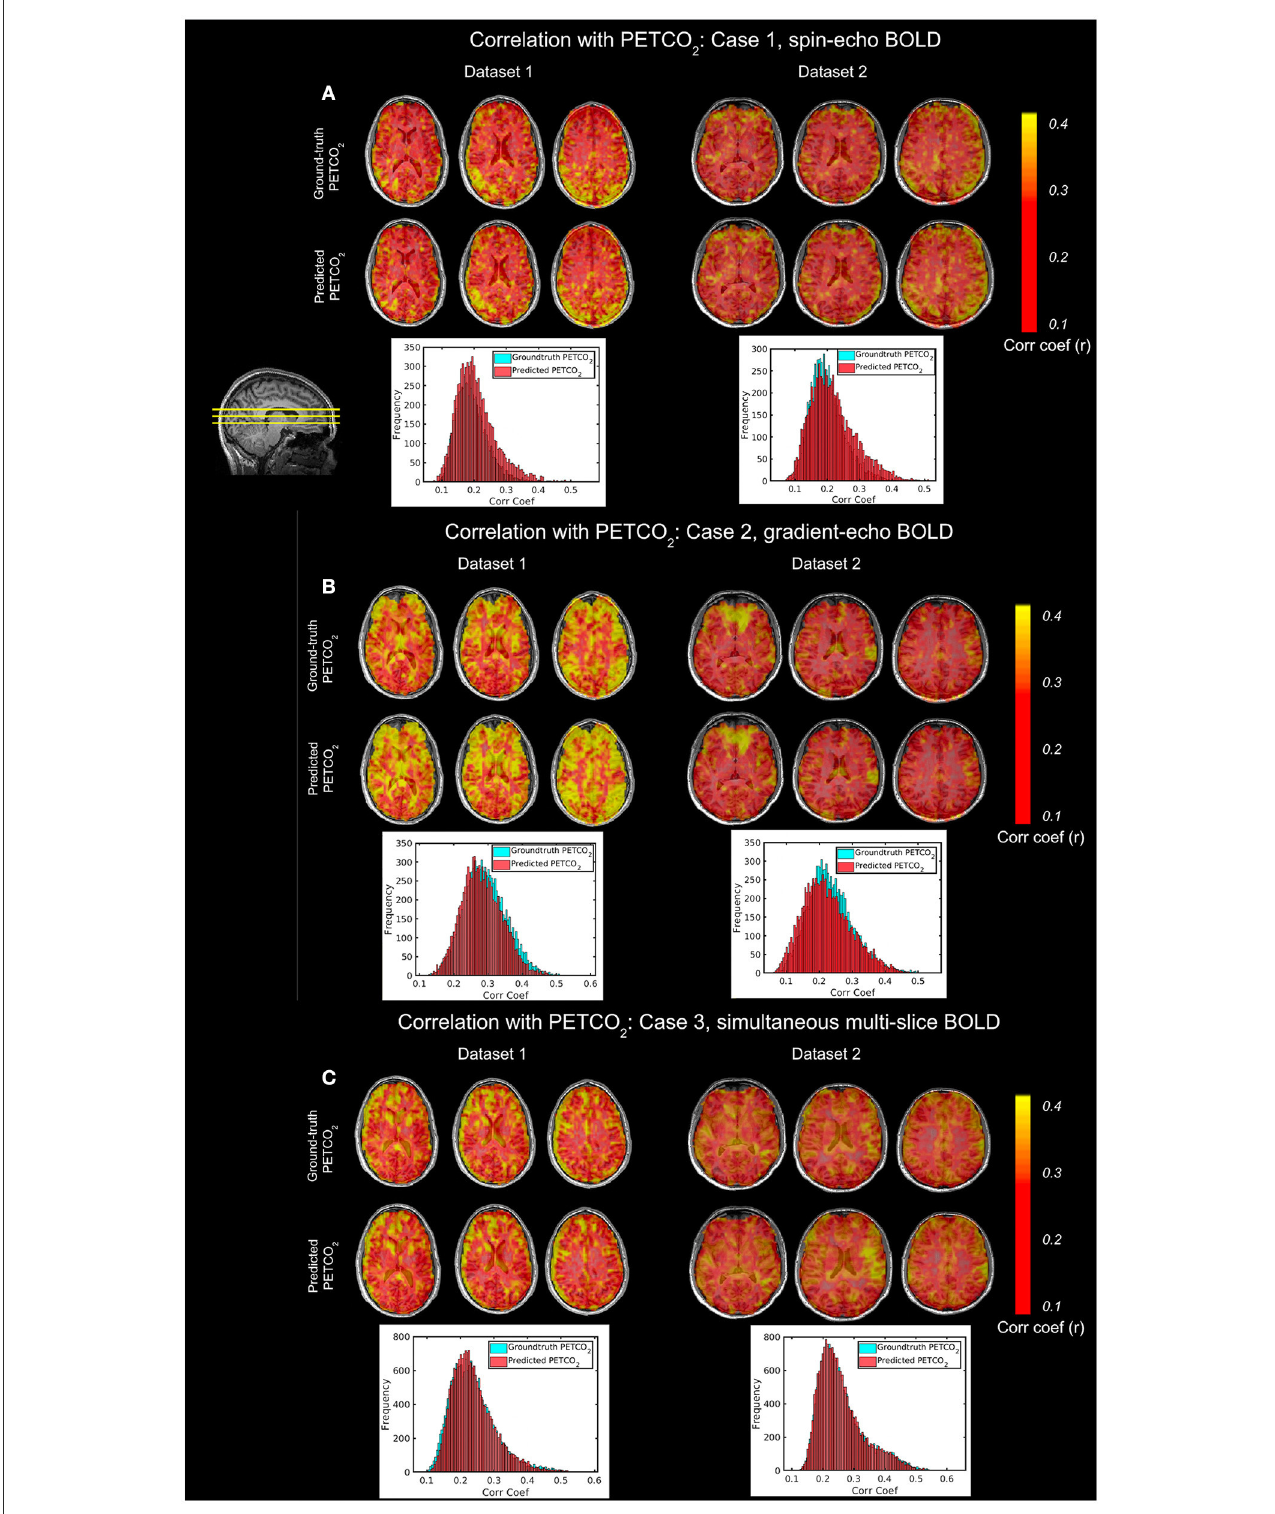
FIGURE8 Comparison of ground-truth and predicted PETCO 2 correlations. Data from 2 different subjects, imaged over multiple sessions [ (A–C) , respectively] are shown. In each case, the peak cross-correlation maps generated using the ground-truth and predicted PETCO 2 time courses are shown in upper and lower rows, with the corresponding correlation-coefficient histograms showing the comparability of the maps. The slice positions are shown by the yellow lines on the sagittal image in the upper-left